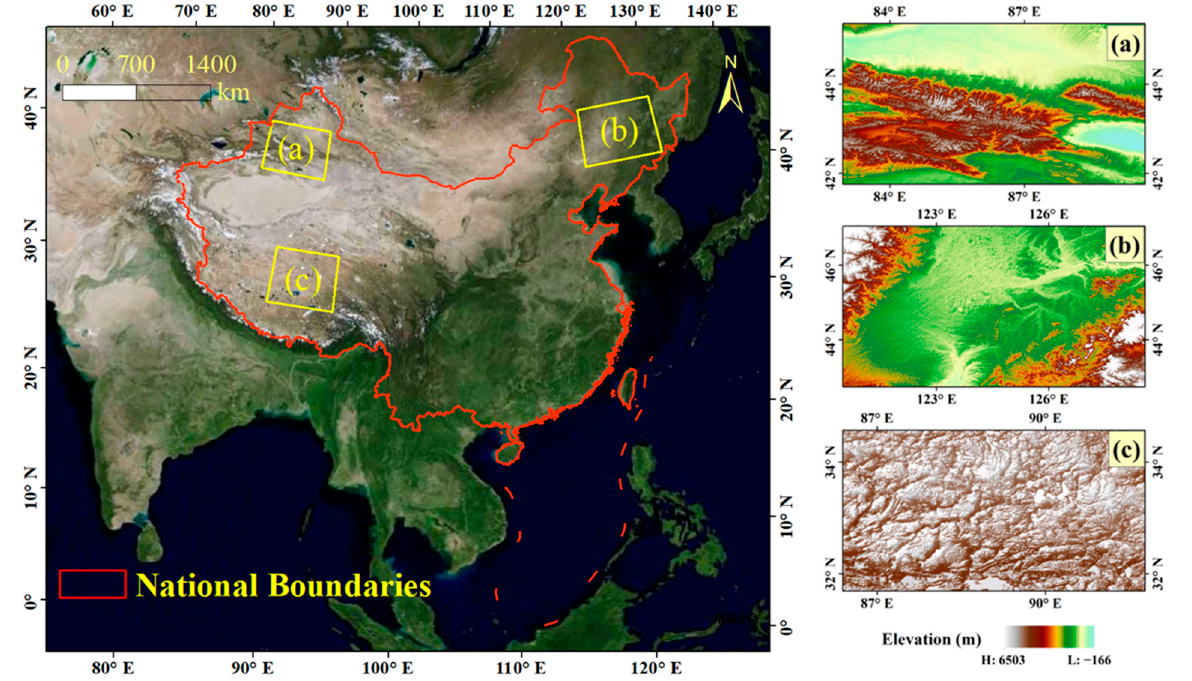
Figure 1. Three test regions in China and their elevations. Three major snow cover regions in China, namely ( a ) Northwest China (NW), ( b ) Northeast China (NE) and ( c ) the Qinghai–Tibet Plateau (QT), are shown as yellow boxes on the left. On the right are elevation maps of the study areas.